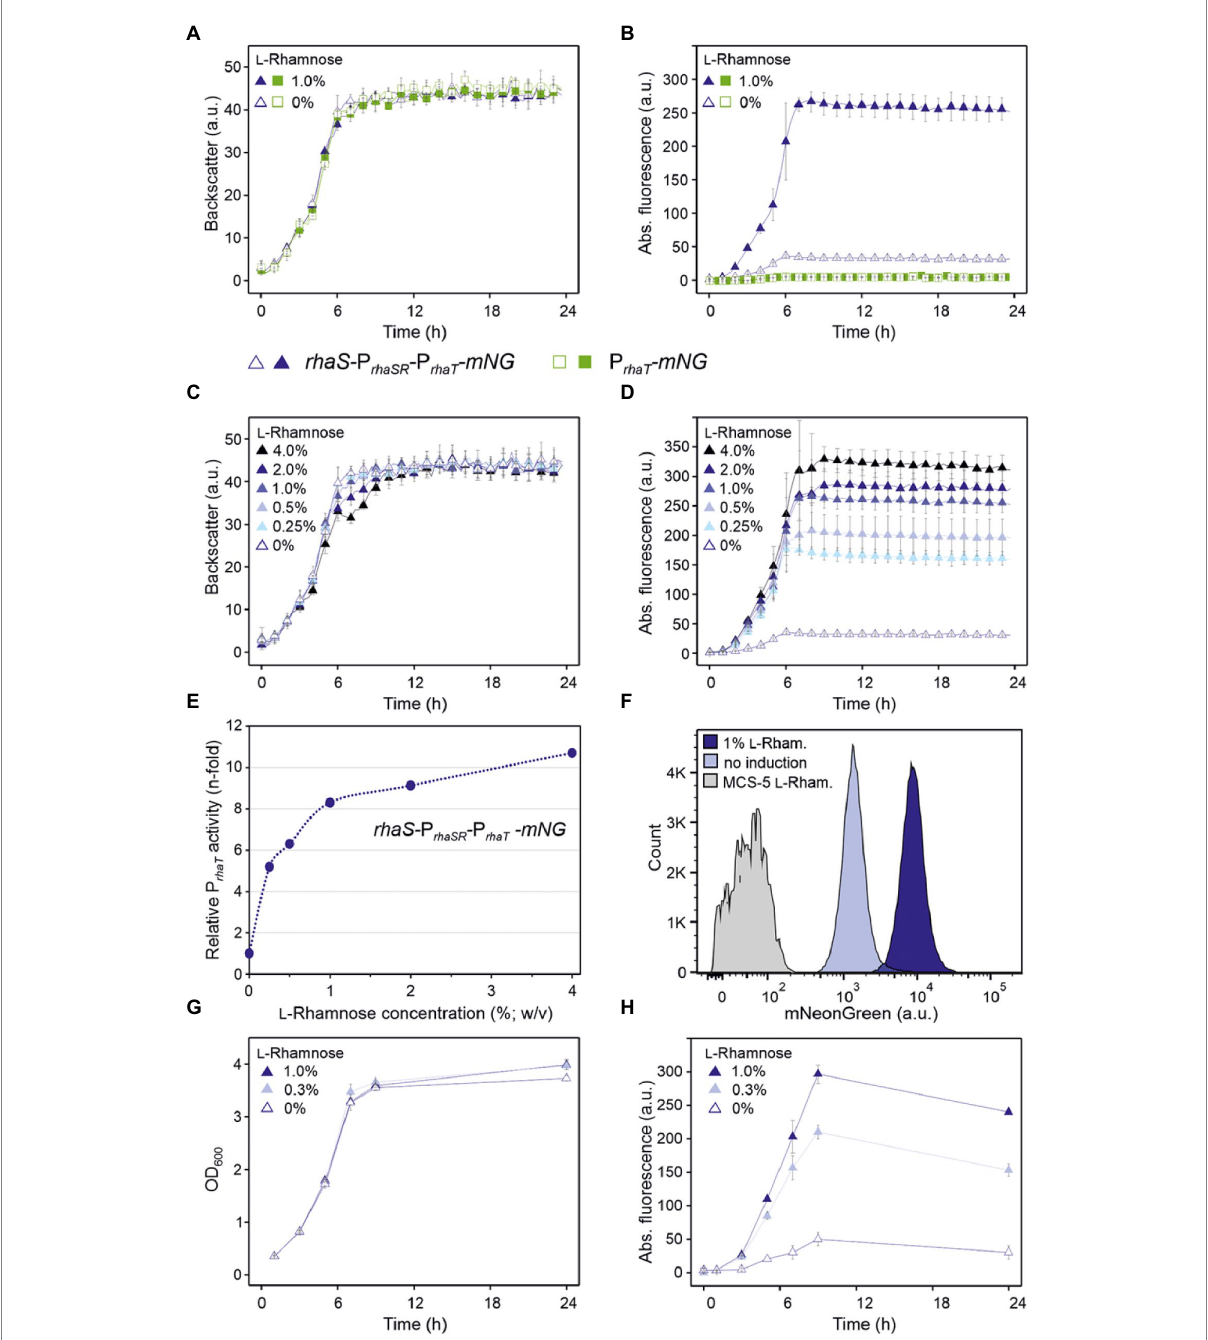
FIGURE 10 Performance of the RhaS-P rhaT system in G. oxydans 621H. (A) Growth according to backscatter and (B) absolute mNG fluorescence of G. oxydans 621H carrying plasmid pBBR1MCS-5- rhaS -P rhaSR -P rhaT - mNG or pBBR1MCS-5-P rhaT - mNG lacking rhaS in microscale BioLector cultivations without and with 1% (w/v) l -rhamnose. (C) Growth (backscatter) and (D) absolute mNG fluorescence of G. oxydans 621H carrying plasmid pBBR1MCS-5- rhaS -P rhaSR -P rhaT -mNG in microscale BioLector cultivations with l -rhamnose concentrations from 0.25% to 4% (w/v) as indicated. BioLector settings: backscatter gain 20, fluorescence gain 70. (E) Correlation between the relative n-fold P rhaT activity in G. oxydans 621H carrying plasmid pBBR1MCS-5- rhaS -P rhaSR -P rhaT - mNG and the l -rhamnose concentrations. For the calculation, the maximal mNG fluorescence in the absence of l -rhamnose was set to 1. (F) FACS analysis of G. oxydans 621H carrying plasmid pBBR1MCS-5- rhaS -P rhaSR -P rhaT - mNG or empty vector pBBR1MCS-5 (MCS-5) as a control. Cells were grown in shake flasks with d -mannitol medium without and with 1% (w/v) l -rhamnose. FACS analysis was performed 7 h after inoculation (induction). Total counts per sample represent 100,000 events. (G) Growth (OD 600 ) and (H) l -Rhamnose-induced mNG fluorescence of G. oxydans 621H carrying plasmid pBBR1MCS-5- rhaS -P rhaSR -P rhaT -mNG in shake flask cultivations with d -mannitol medium. The mNG fluorescence was measured in a Tecan reader (gain 60). All data represent mean values and standard deviation from two biological replicates (clones) with three technical replicates